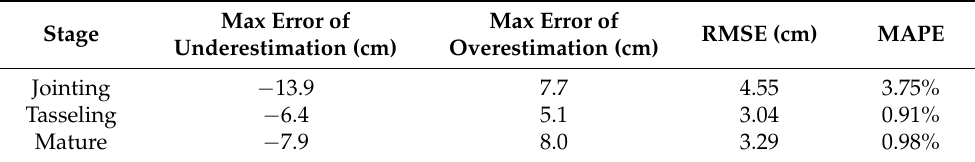
Table 4. Statistics of maize height estimation accuracies at three growth stages.